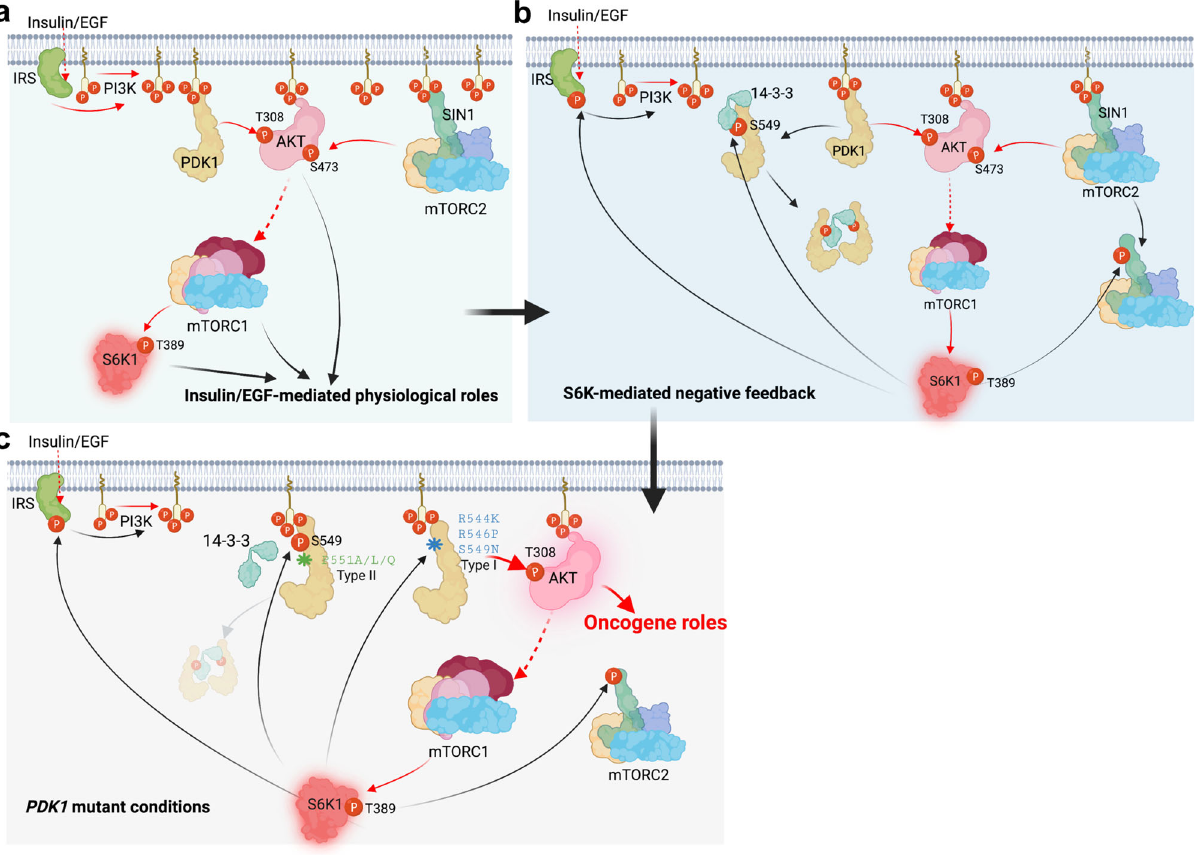
Fig. 7 Models depicting the negative regulation of PDK1 by S6K1 under physiological and pathological conditions. a The canonical activation of PI3K- AKT-mTOR pathway toward growth factors, such as Insulin or EGF treatment. b The negative feedback regulations of AKT kinase by S6K1-mediated phosphorylation of SIN1, PDK1 as well as IRS1. Among which, phosphorylation of IRS1 decreases PI3K-mediated PIP 3 generation; phosphorylation of SIN1 dissociates mTORC2 from membrane location; phosphorylation of PDK1 recruits 14-3-3 and dissociates from membrane location. These pathways together tightly negatively control growth factors-induced constant activation of AKT kinase. c Patient-associated PDK1 mutations could block S6K-mediated PDK1 phosphorylation (Type I mutations) or 14-3-3-mediated PDK1 membrane dissociation (Type II mutations), leading to AKT constitutive activation and oncogenic roles, such as accelerating cell proliferation and anti-apoptosis. Red and black arrows indicate positive and negative regulation, respectively. Solid and dotted lines indicate direct and indirect (multistep) regulation, from Cell Signaling Technology. Anti-pS6K1 (Thr229) antibody (ab5231, 1:1000) was obtained from Abcam. Polyclonal anti-HA antibody (sc-805, 1:1000) was obtained from Santa Cruz. Polyclonal anti-Flag antibody (F-2425, 1:1000), mono- clonal anti-Flag antibody (F-3165, clone M2, 1:3000), anti-Tubulin antibody (T-5168, 1:3000), anti-Vinculin antibody (V4505, 1:3000), anti-Flag agarose beads (A-2220), anti-HA agarose beads (A-2095), peroxidase-conjugated anti-mouse sec- ondary antibody (A-4416) and peroxidase-conjugated anti-rabbit secondary anti- body (A-4914) were obtained from Sigma. Glutathione Sepharose 4B (17-0756-05) was obtained from GE Healthcare, Monoclonal anti-HA antibody (901503, 1:3000), anti-GAPDH (649201, 1:3000) antibody was obtained from Biolegend. The polyclonal phosphorylation antibodies against pS549-PDK1 (1:1000) generated by Abclonal Technology were derived from rabbit with four clones. The antigen sequence used for immunization was PDK1 aa544-552 (C-RQRYQ S HPD). S stands for phosphorylated residue in this synthetic peptide. The antibodies were af fi nity puri fi ed using the antigen peptide column, but they were not counter selected on unmodi fi ed antigen.